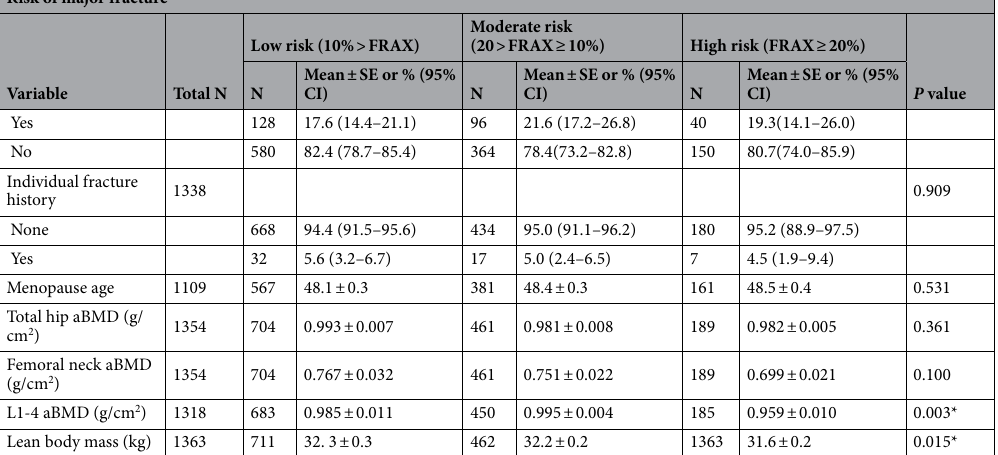
Table 2. Differences of oral health status, history related with fracture risk, bone mineral density, lean body mass according to the levels of probable risk of major fracture. aBMD, areal bone mineral density; CI, confidential interval; CPI, community periodontal index; DMFT, decay, missing, filling tooth; SE, standard error. %Weighted percentage by column. Data obtained from independent T-test. Descriptive values are shown as mean ± SE. † Data obtained from Rao-Scott Chi-square test and descriptive values are show as % (95% CI). *P < 0.05, ** P < 0.001 by independent T-test and Rao-Scott Chi-square